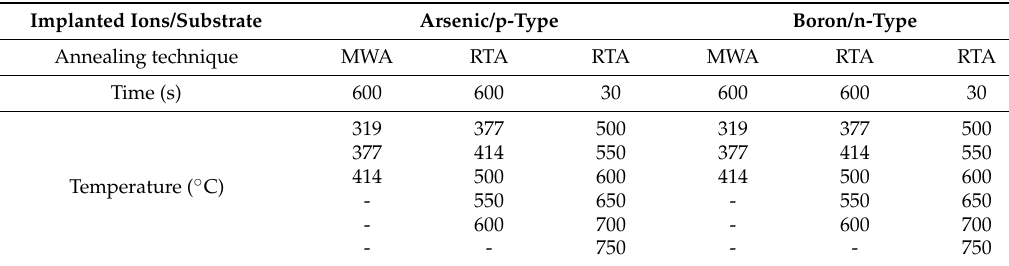
Table 1. Annealing temperature and duration for both microwave annealing (MWA) and rapid thermal annealing (RTA) techniques. (The corresponding microwave power for 319 ˝ C, 377 ˝ C, and 414 ˝ C MWA are 2100 W, 2800 W, and 3500 W,